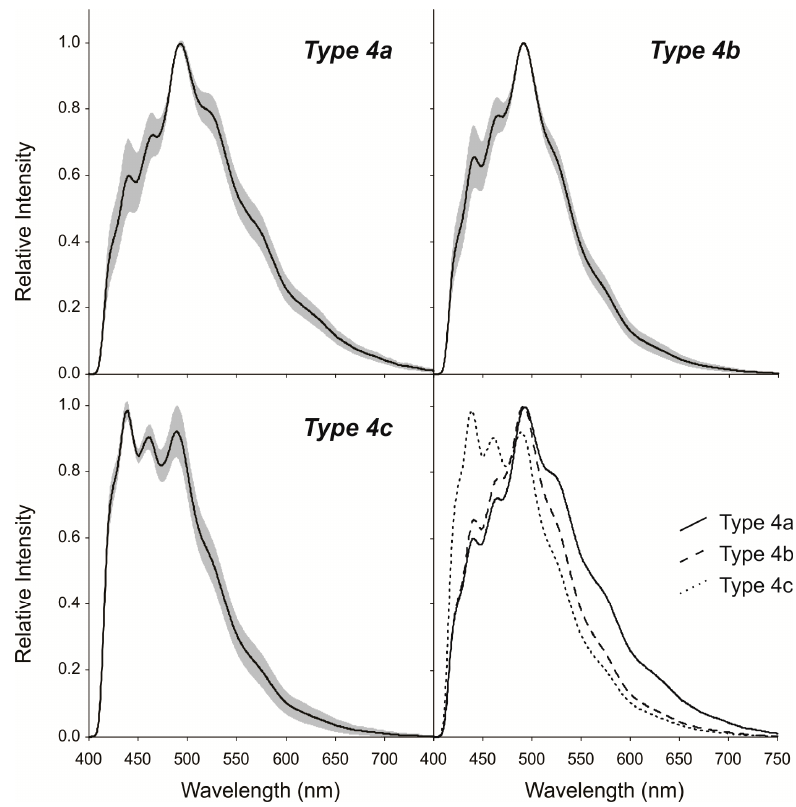
Figure 7. Ultraviolet fluorescence spectra for Type 4a, 4b and 4c inclusions. Solid black line represents an average spectrum, grey shaded area represents standard deviation. Bottom right diagram displays averages for all three inclusions types, showing progressive shift of intensity to lower wavelengths from Type 4a to Type 4c inclusions.